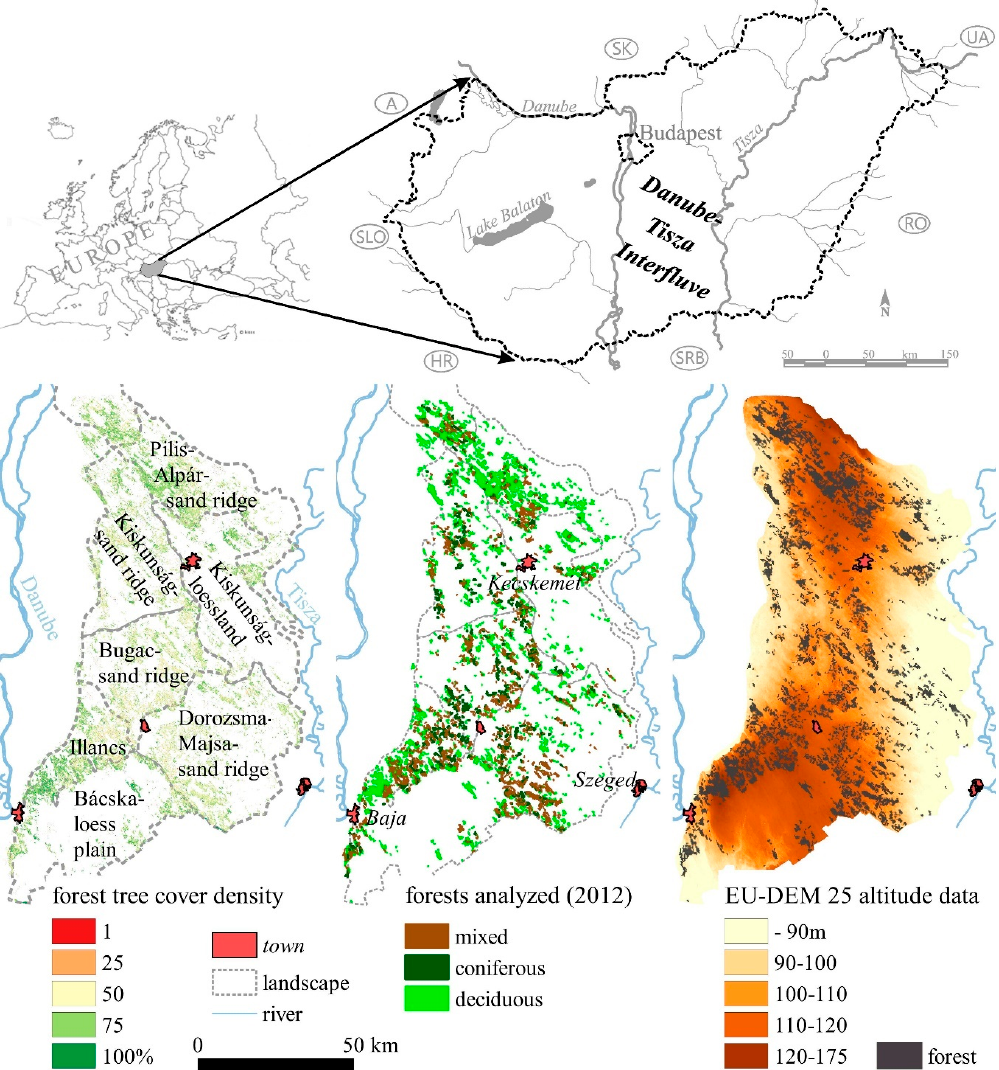
Figure 1. Characterization of forests analyzed on the Danube − Tisza Interfluve in Hungary; based on data: [6,10,11]. data: